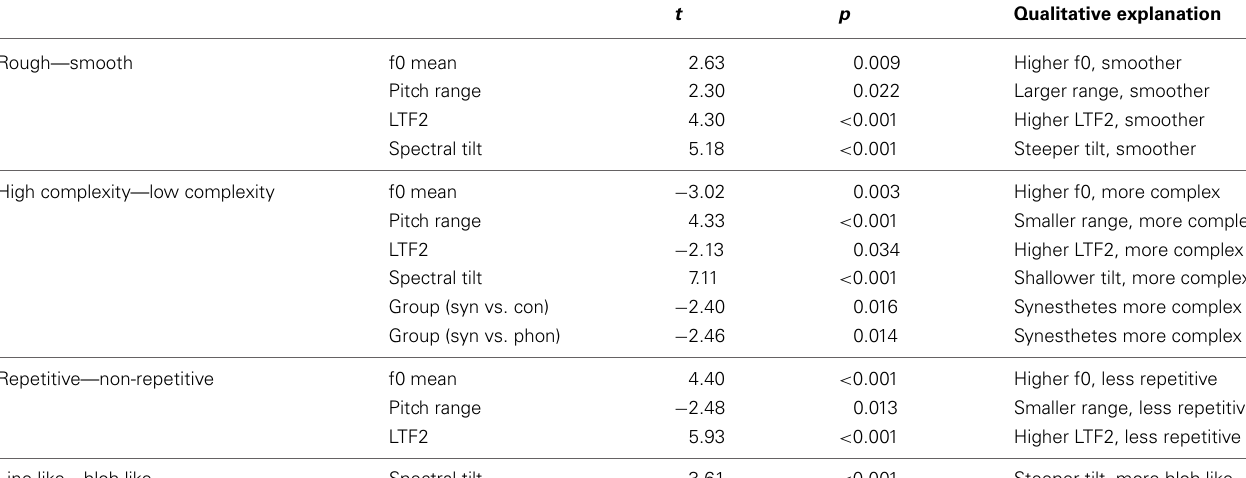
Table 6 | Results of linear mixed effects modeling testing acoustic influences on participants’ texture